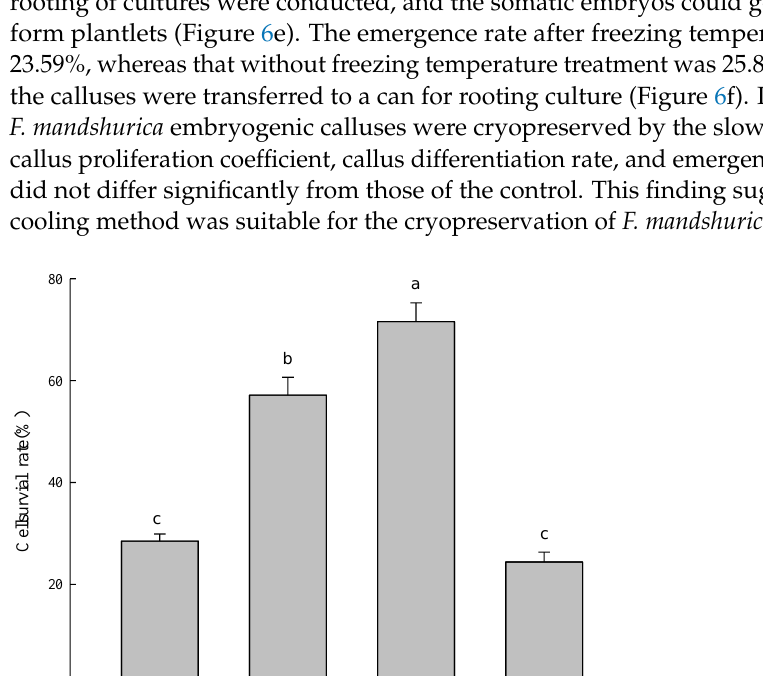
Table 8. Changes in the fresh weight of F. mandshurica embryogenic callus with culture under dif- ferent cryoprotection times.